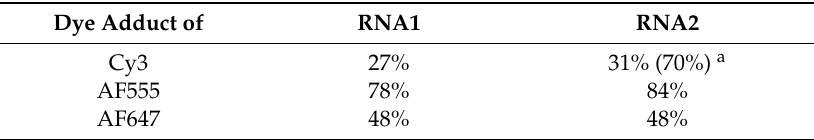
a after reaction in the presence of 10.0 equiv. Cy3-maleimide.